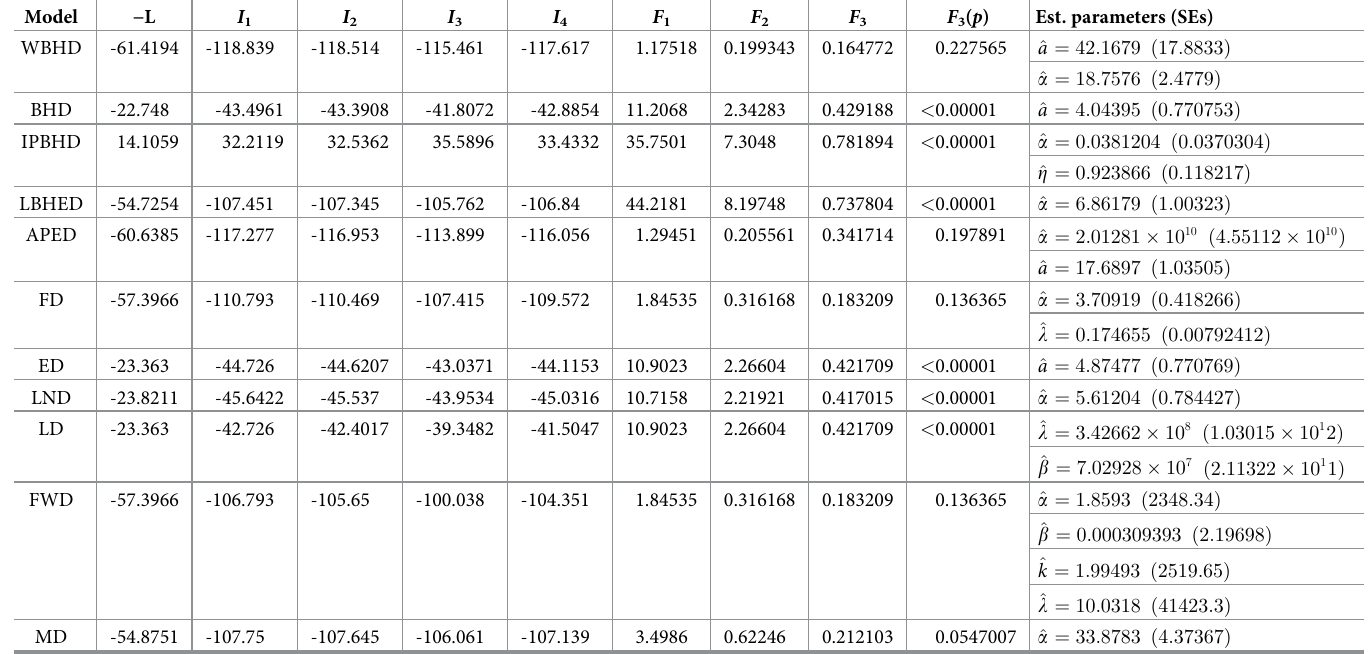
Table 10. Numerical values for analyzing the second COVID-19 real data set.